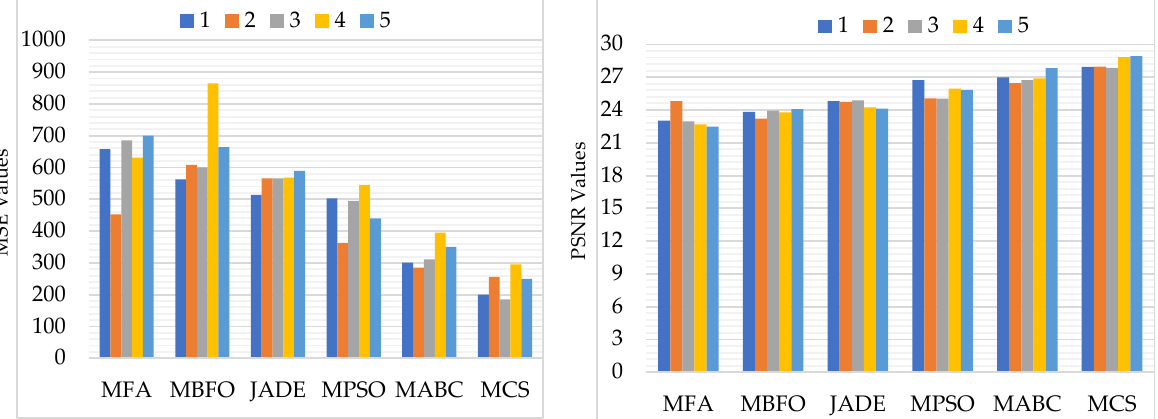
Figure 14. CPU time using different optimization algorithms with Rényi’s entropy.